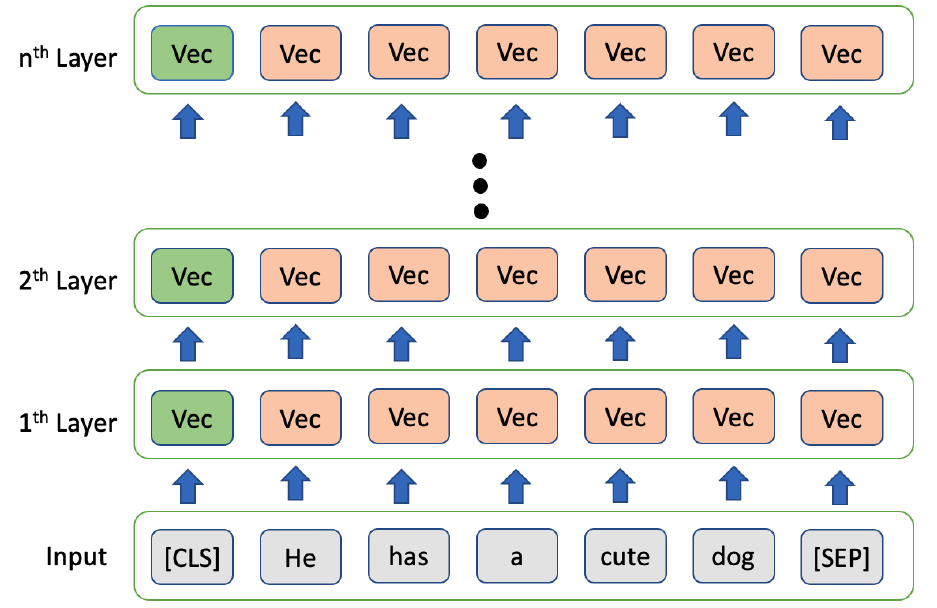
Figure 2. An attention vector is generated for each word corresponding to each layer in the